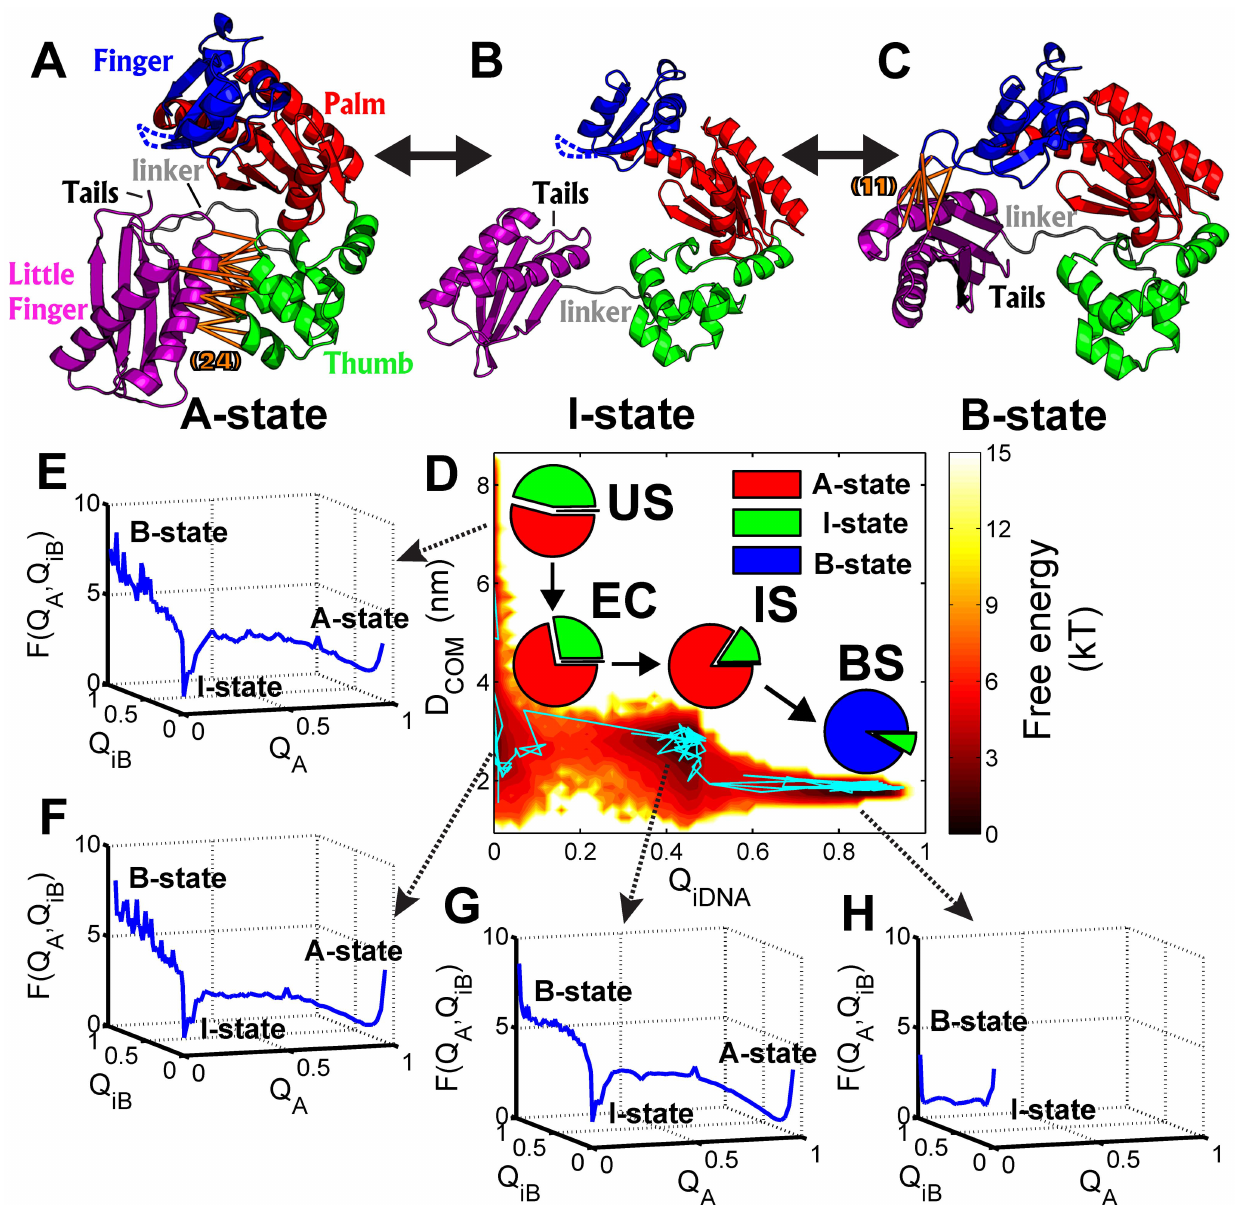
Figure 1. Structural representation of DPO4 and free energy landscapes. The structure of the A-, I- and B-states of DPO4 are shown in (A), (B) and (C), colored by: the F domain, blue; the P domain, red; the T domain, green; the LF domain, purple; the linker between the LF and T domain, grey. The specific interactions formed by the LF domain with the T domain in the A-state and the F domain in the B-state are drawn by orange lines in (A) and (C), and the number of the specific interactions are indicated in parentheses, respectively. The unstructured loop in the F domain is shown by the blue broken lines in (A) and (B). (D) The binding free energy is shown as a function of Q iDNA and D COM at T ~ 1 : 25 E LJ . Q iDNA describes the native similarity of binding of DPO4 to DNA, D COM describes the distance between DPO4 and DNA. The four free energy minima correspond to different binding stages: the US, EC, IS and BS. A constant temperature simulation at T ~ 1 : 25 E LJ was performed and the trajectory is shown to validate the continuity of the adjacent stages in free energy landscapes. (E–H) The free energy landscapes of conformational dynamics in DPO4 are shown as a function of Q A and Q iB at each binding stage. Q A , Q iB measures the native similarity of the LF domain interacting with the T domain in the A-state and the F domain in the B-state, respectively. The A-, I- and B-states of DPO4 can be observed in the US, EC and IS, with different population distributions at different binding stages. Only the I- and B-state of DPO4 can be observed in the BS. The populations of the three states of DPO4 at each binding state are plotted as pie-charts in (D) near the corresponding free energy minima. combining with additional constant temperature simulation the stage with intermediate states(IS) and the stage with binding trajectory showed that the DPO4-DNA binding proceeds with states (BS), corresponding to typical biomolecular recognition [56]. four kinetically connected stages, including the stage with In detail, we found that DPO4 undergoes conformational dynamics at each stage during DNA recognition from the free unbinding states (US), the stage with encounter complex (EC),